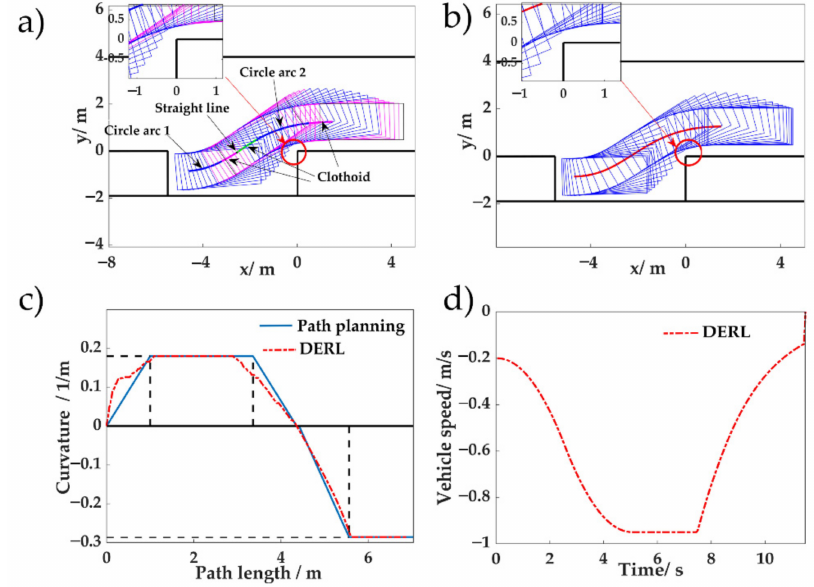
Figure 10. Vehicle trajectories given by di ff erent methods: ( a ) Ideal trajectory of the planned path using continuous-curvature curve-based method; ( b ) vehicle trajectory of the proposed RL method; ( c ) path curvatures of di ff erent methods; and ( d ) vehicle speed command of the proposed RL